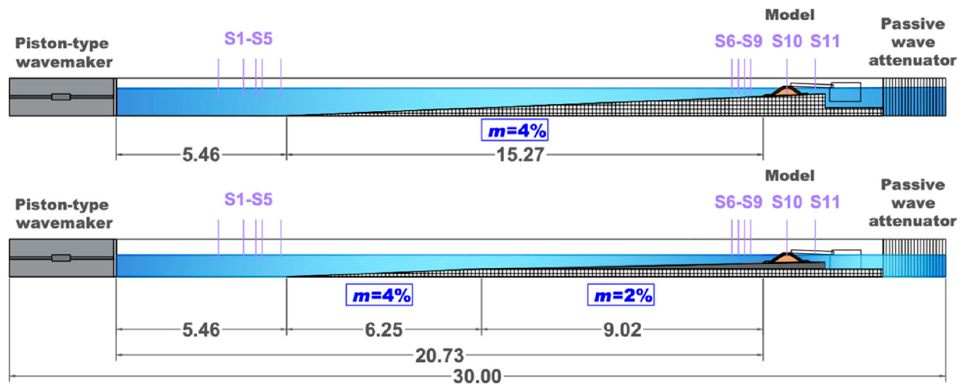
Figure 1. Longitudinal cross-sections of the configurations at the LPC-UPV wave flume. Mound breakwaters with armor slope H/V = 3/2 and rock toe berms were tested. Three armor layers were considered: (1) double-layer randomly placed rock (rock-2L with D n 50 = 3.18 cm), (2) double-layer randomly-placed cube (cube-2L with D n = 3.97 cm) and (3) single-layer Cubipod ® (Cubipod ® -1L with D n = 3.79 cm). The initial packing density